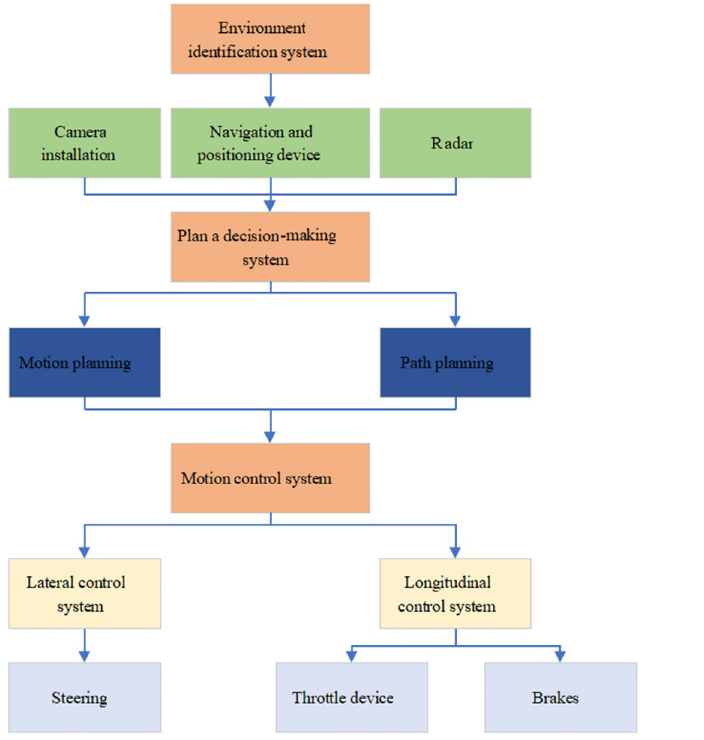
Fig 1. Intelligent autonomous vehicle